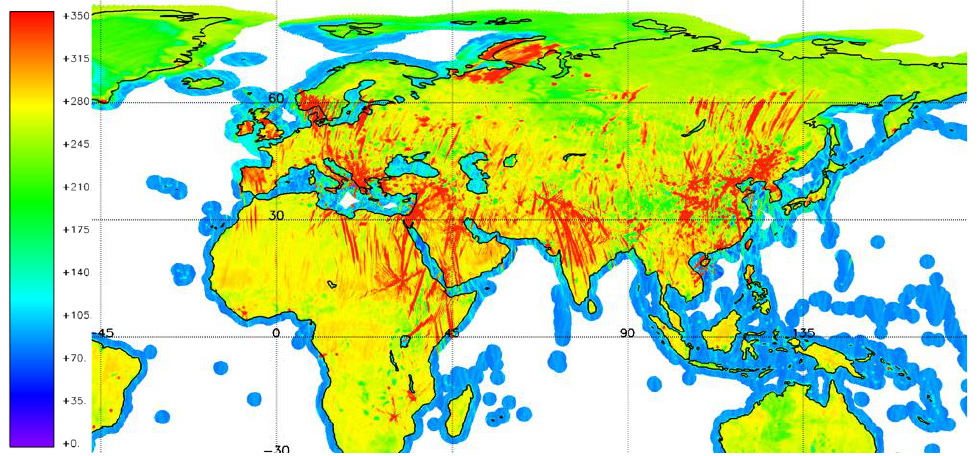
Figure 1. SMOS BT Map averaging 88 L1C products generated in December 2009.